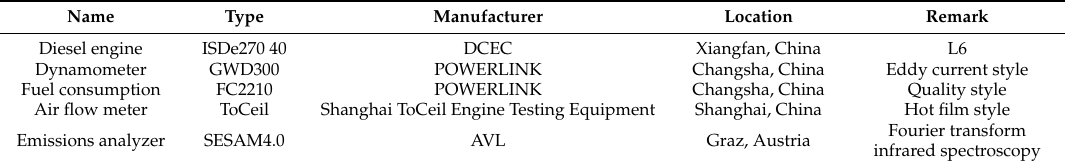
Table 1. Specifications of main equipment.